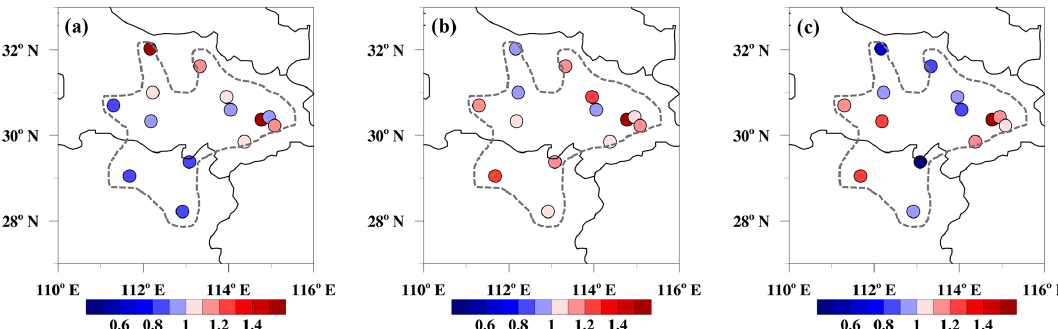
Figure 7. Spatial distributions of the ratios of linear trends in long-term components ( k LT ) and emissions-related long-term compo- nents ( k emiss ) of (a) PM 2 . 5 , (b) SO 2 and (c) NO 2 at 14 sites in the THB over 2015–2019.